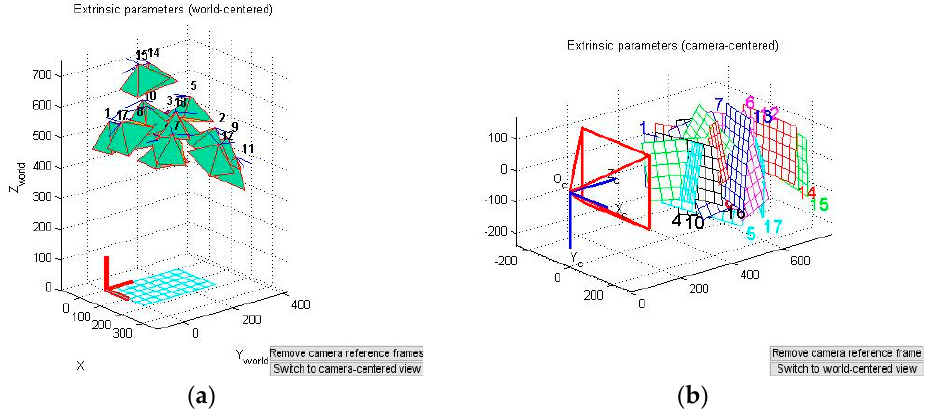
Figure 6. The relative positions and angles of the camera and the calibration plate. ( a ) Camera coordinate system. ( b ) World coordinate system.